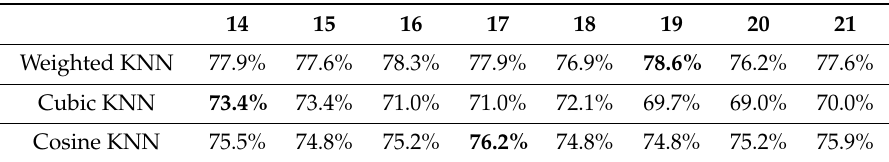
Figure 8. Cosine KNN Confusion Matrix. Table 3. K-Nearest Neighbors Comparison.